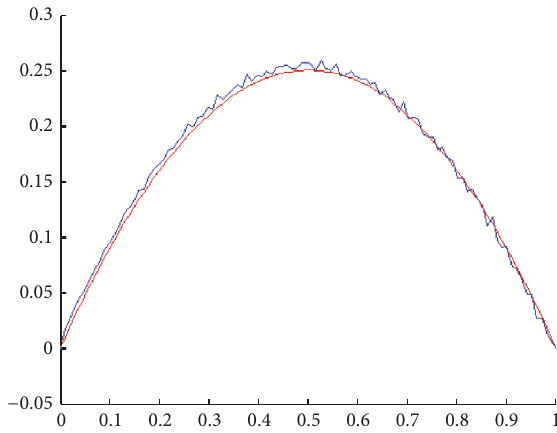
Figure 2: Final temperature.